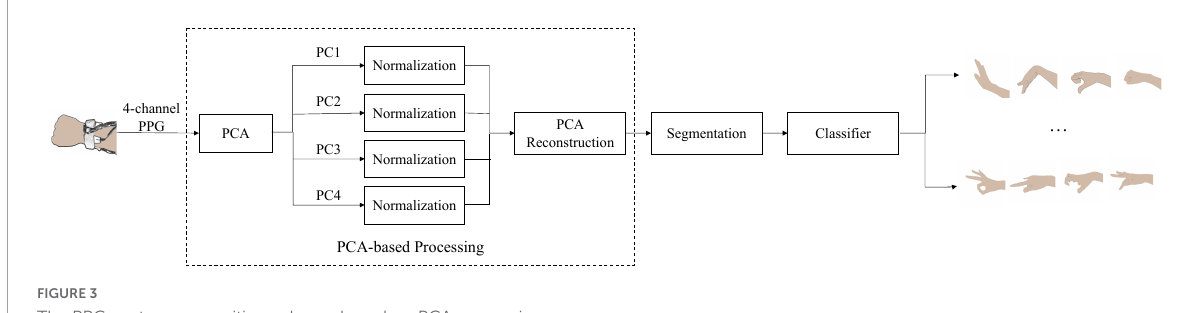
FIGURE3 The PPG gesture recognition scheme based on PCA processing.